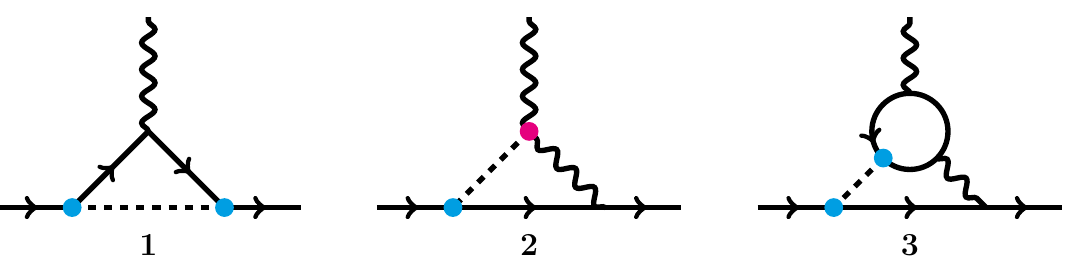
Figure 1 . Feynman diagrams for contributions to lepton g − 2 . The cyan dots represent insertions of a derivative coupling of the form (2.6). The magenta dot represents an insertion of an aF ˜ F coupling. Unmarked vertices are ordinary gauge